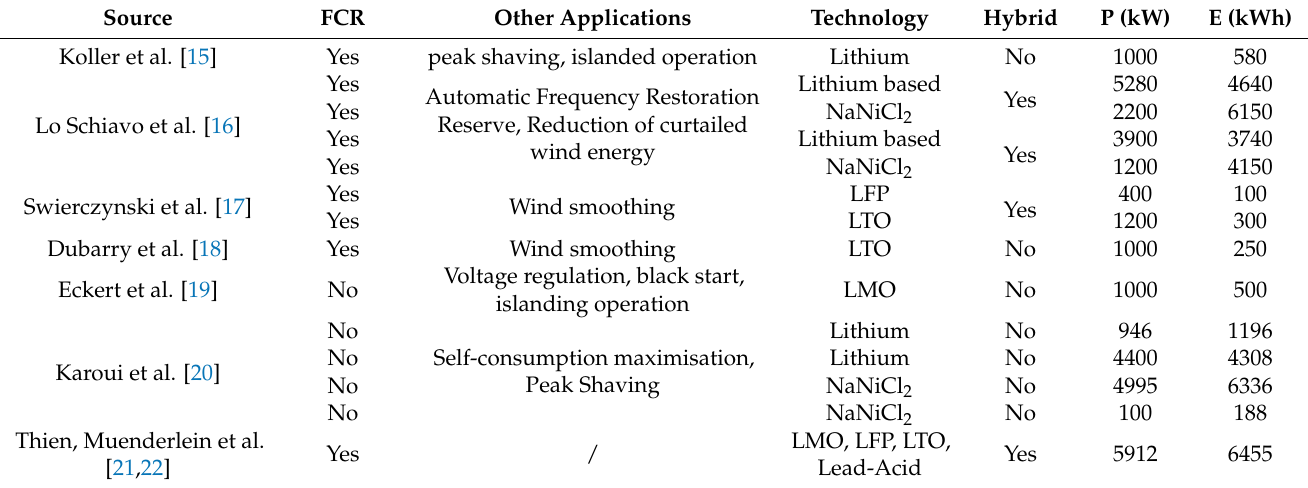
Table 1. Literature review on LSS with reference to field